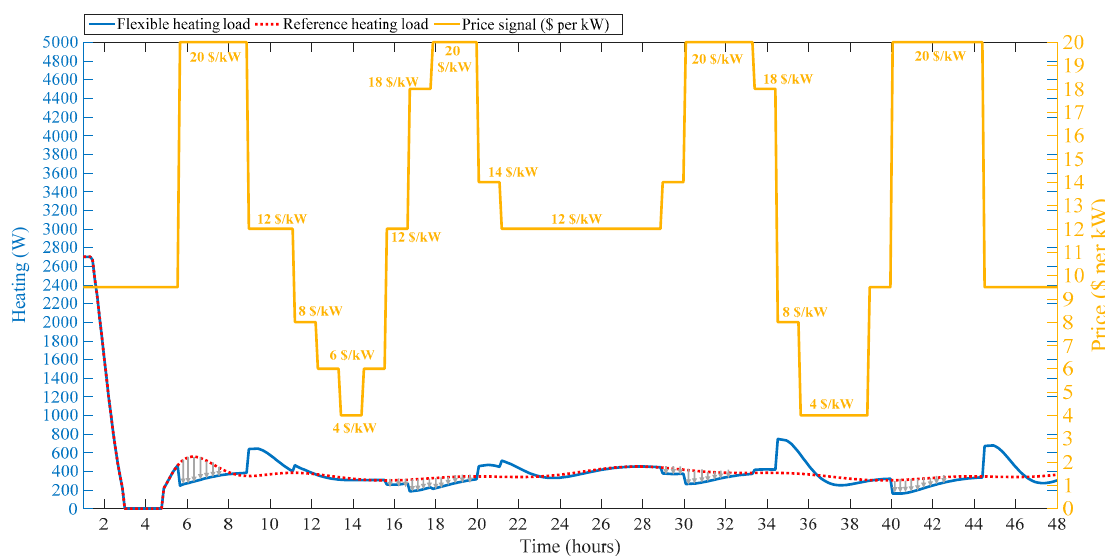
Figure 12. BEFI during high price signal periods.